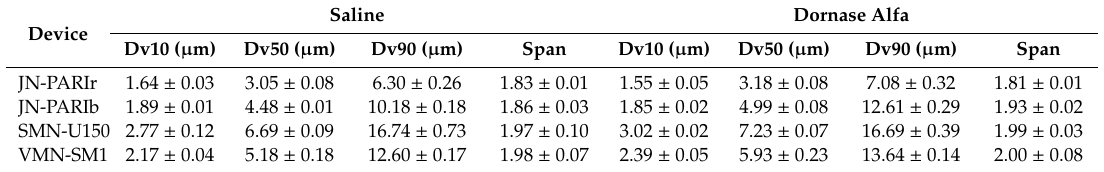
Table 2. Aerosol droplet sizes for saline and dornase alfa generated by the four nebulizers.